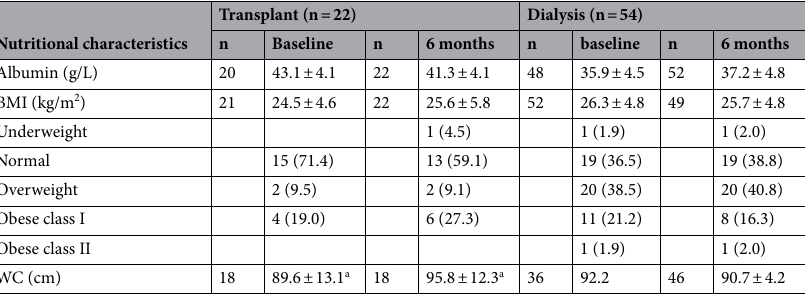
Table 2. Nutritional characteristics of transplant candidates and recipients (N = 76). Data expressed as percentages or means with standard deviation or frequency with percentages. a WC is significantly larger at 6 months than at baseline, paired samples t-test: t(14) = − 2.861, p